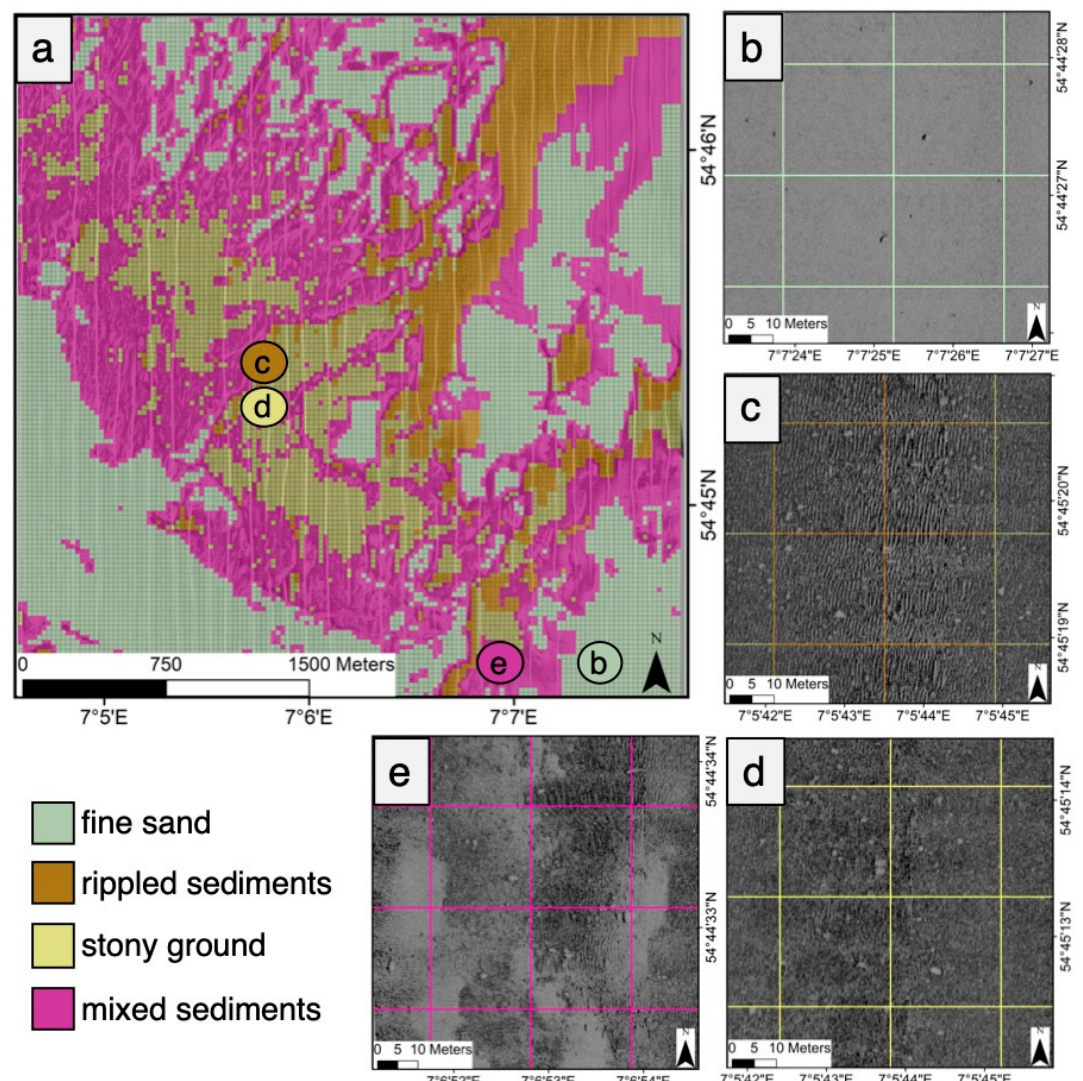
Figure 8. Locations of the different sediment types within the study area based on 25 × 25 m grid cells ( a ). Close-up views of the sediment types are given in b – e . Dark colors of the SSS mosaic represent high backscatter and bright colors represent low backscatter values.